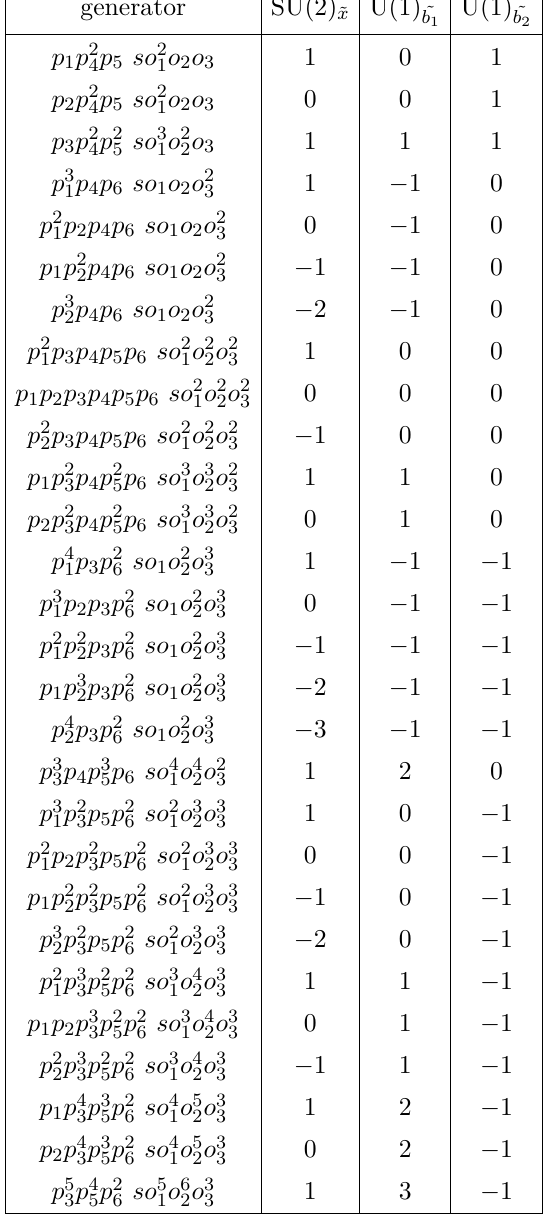
Table 32 . The generators and lattice of generators of the mesonic moduli space of Model 8 in terms of brick matchings with the corresponding flavor